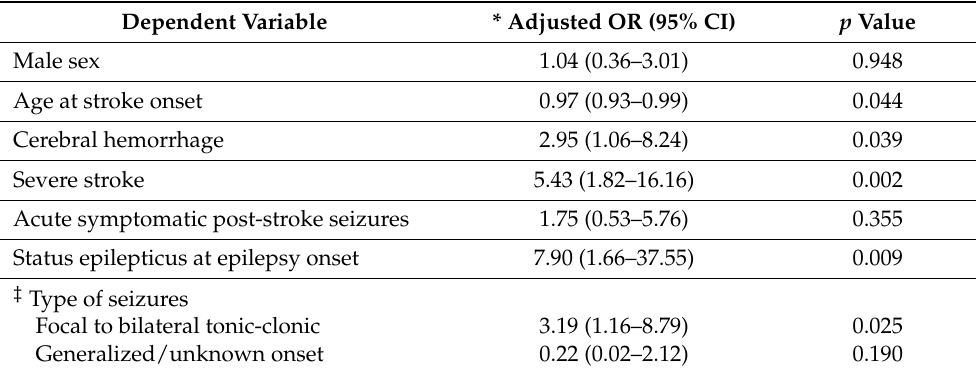
Table 2. Association between baseline characteristics and